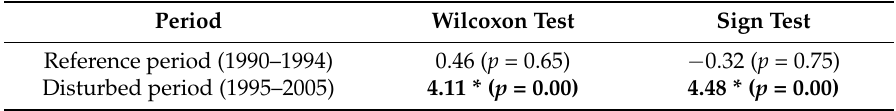
Table 4. Wilcoxon test and Sign test for predicted and observed accumulated streamflow in reference and disturbed periods.